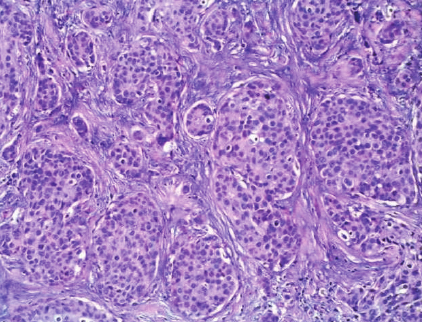
Figure 2: Lymph node with metastasis, nests of tumor cells, 100% expression of synaptophysin, × 40.